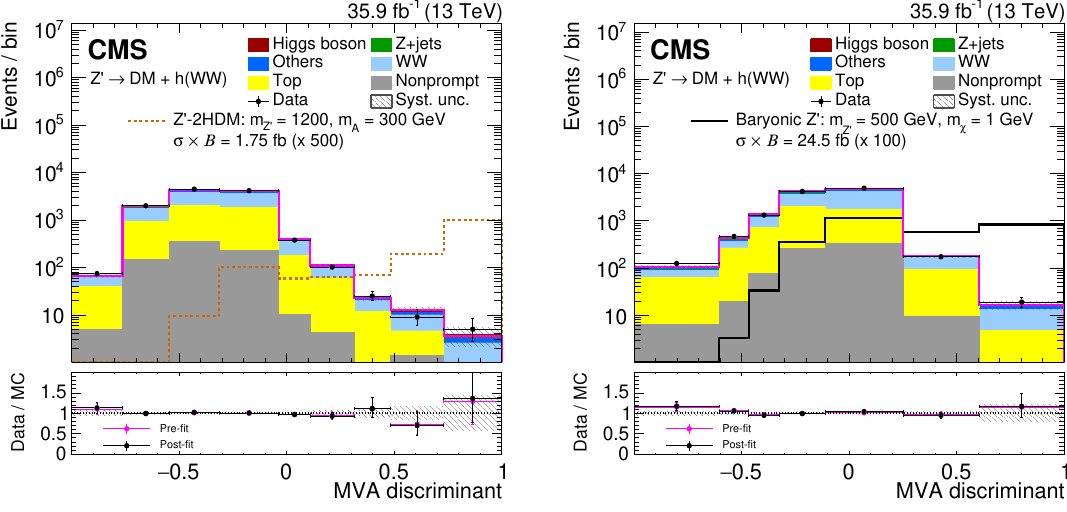
Figure 5 . The distribution of the BDT discriminants expected from MC simulation before and after the (cid:12)t, and observed in data (points with error bars) for the Z 0 -2HDM (left) and baryonic Z 0 (right) model in the signal region in the h WW analysis. Two signal benchmarks, corresponding to the ! Z 0 -2HDM (dotted orange line, left) and baryonic Z 0 (solid black line, right) model are superimposed. The signal is normalized to the product of cross section and , where represents the h WW B B ! branching fraction. The signal distributions are scaled up by a factor 500 (100) for the Z 0 -2HDM (baryonic Z 0 model), to make them more visible. The systematic uncertainties are shown by the hatched band. The lower panel shows the ratio of data to the total background yield, before and after the